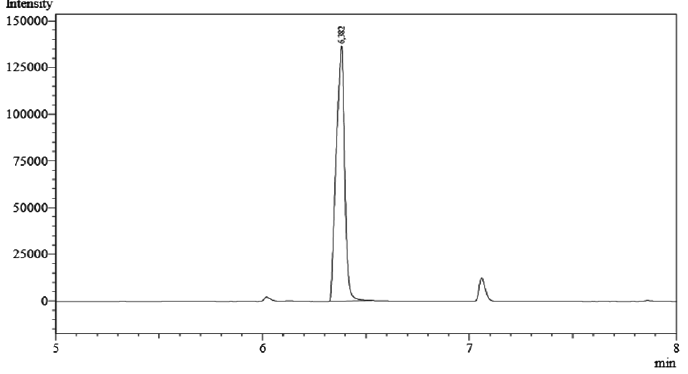
Fig. 3. Chromatogram of P(3HB) after methanolized into 3-hydroxybutyrate methyl ester at retention time 6.382